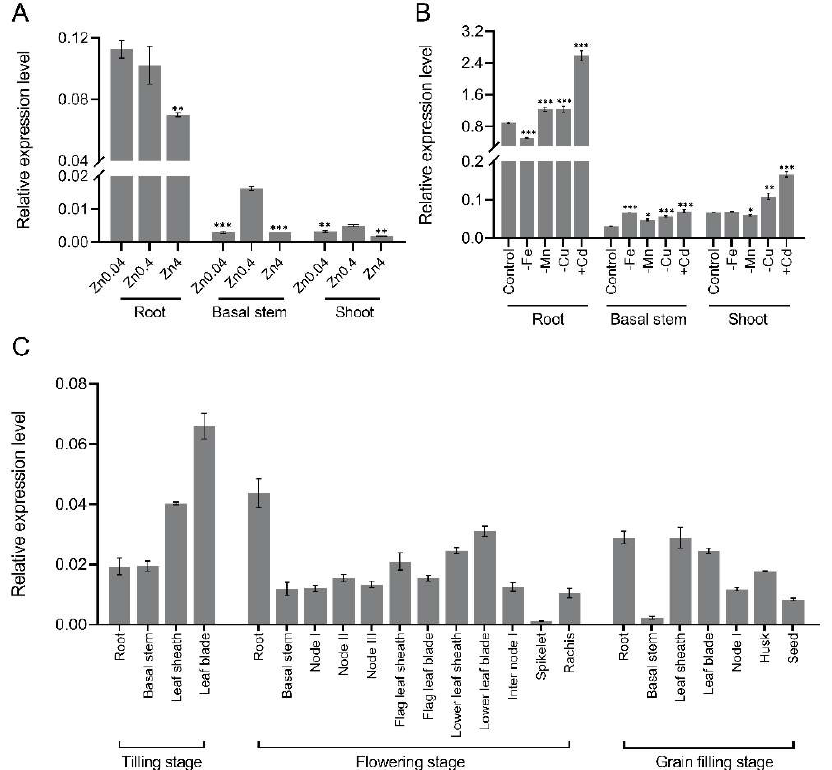
Figure 1. Expression analysis of OsNAC15 . ( A ) Response of OsNAC15 expression to different Zn concentrations. Rice seedlings were grown in the 1/2 Kimura B solution containing 0.04 µ M, 0.4 µ M or 4 µ M ZnSO 4 for 3 days. ( B ) Response of OsNAC15 expression to Cd stress or metal deficiency. Rice seedlings were grown in the 1/2 Kimura B solution with or without Fe, Mn, Cu or Cd for 3 days. Total RNAs were extracted from the roots, basal stems and shoots of the 13 d Nipponbare seedlings. ( C ) Tissue expression of OsNAC15 at different growth stages of plants grown in the field. Data are means ± SD of three biological replicates. *, ** and *** indicate significant differences at p < 0.05, 0.01 and 0.001, respectively, by Student’s t -test.